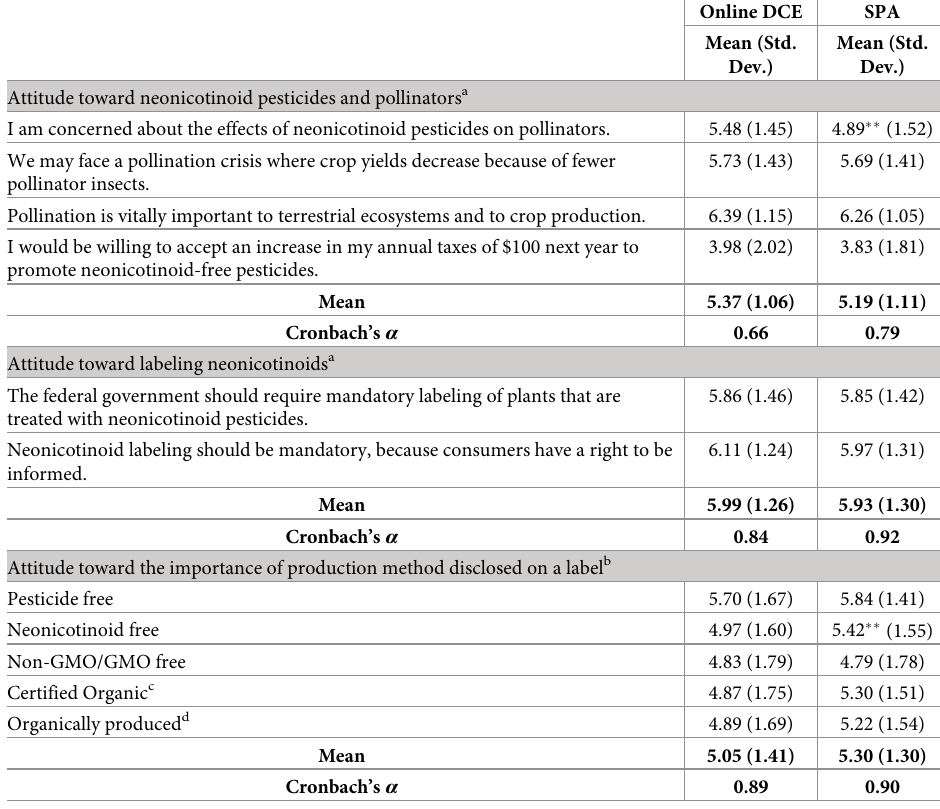
Table 3. Descriptive statistics for attitude scale constructs.